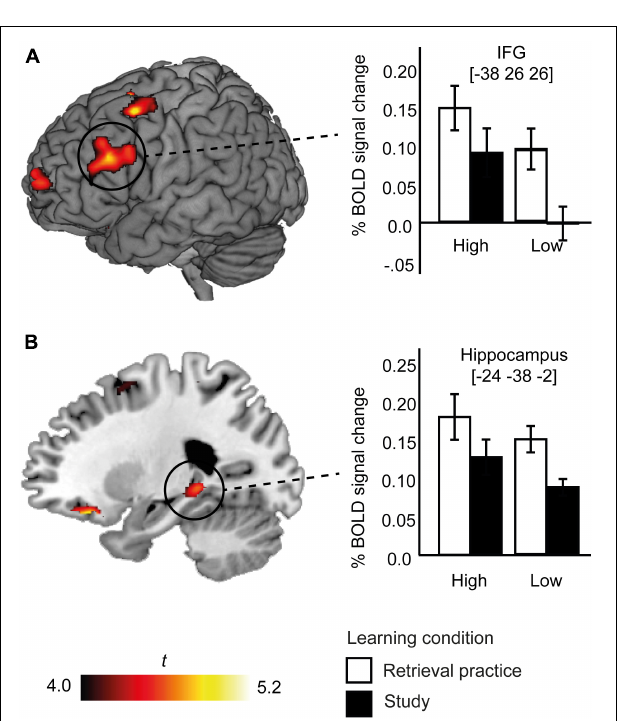
FIGURE 4 | Brain activation related to the two learning condition (retrieval practice and study) × two NFC group (high NFC and low NFC) ANOVA. Brain activity more engaged after retrieval practice > study is illustrated in selected brain regions ( A , the left IFG [ − 38 26 26] and B , the left hippocampus [ − 24 − 38 − 2]). BOLD activity for the retrieval practice and study conditions is plotted separately for the NFC groups (high and low). White bars represent the retrieval practice condition. Black bars represent the study condition. Error bars denote ± 1